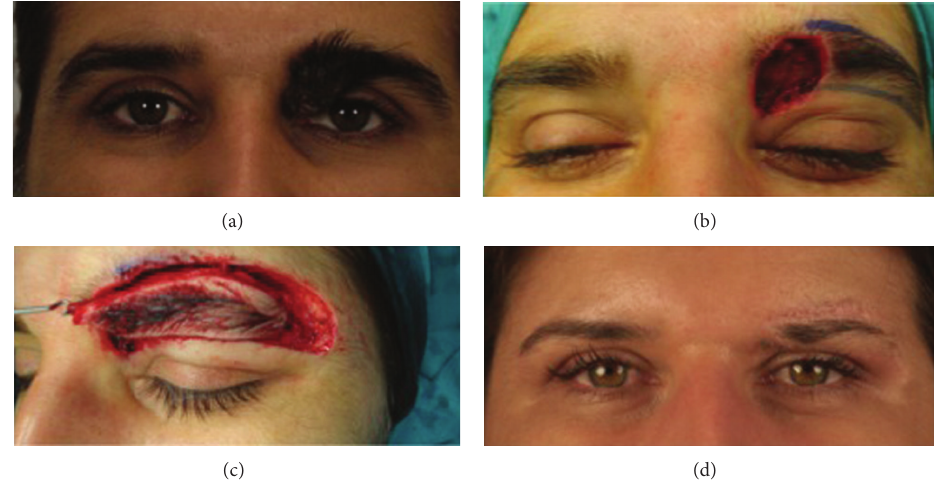
Figure 2: a 35-year-old female patient affected from congenital intradermal melanocytic nevus of the medial portion of the left eyebrow (a). Excision of the nevus was performed, and immediate reconstruction using a freestyle-like V-Y advancement flap was used to cover the defect (b, c). Cosmetic appearance was considered satisfactory at follow up 1-year postoperatively (d).